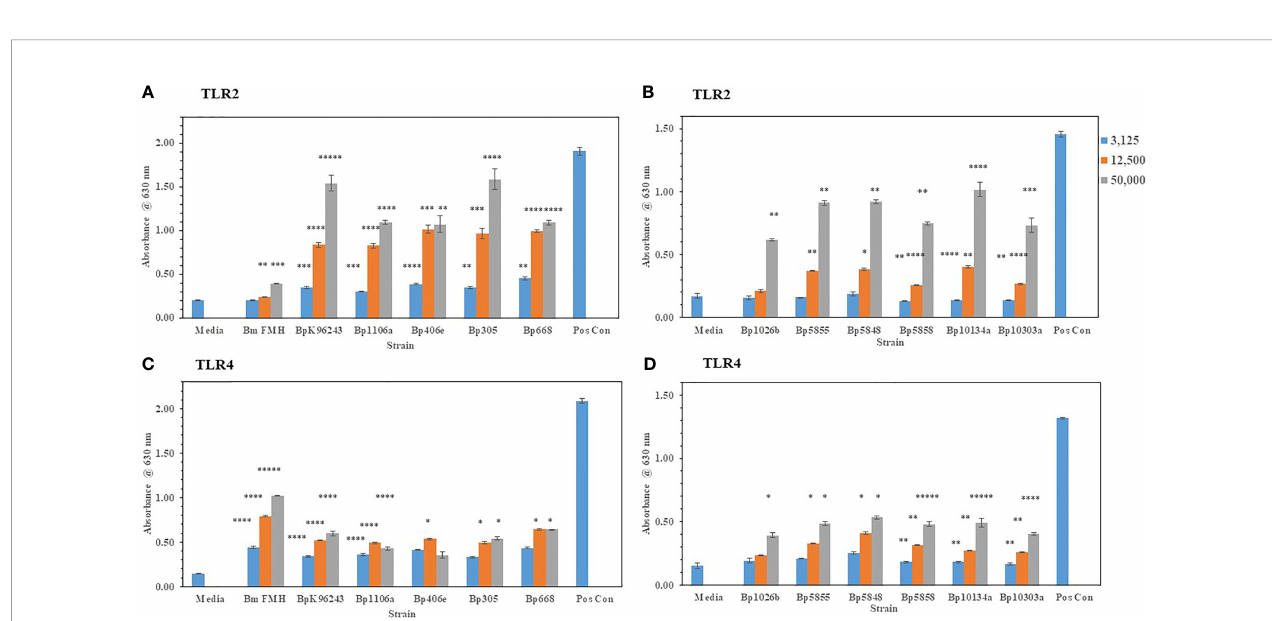
FIGURE 4 | B. mallei ( Bm ) and B. pseudomallei ( Bp ) are closely related species but activate TLR2 and TLR4 differently. Burkholderia spp. were grown at 37°C for ~48 h, and bacterial suspensions were diluted in PBS to inoculate HEK293-TLR2 or -TLR4 cells. The following Burkholderia spp. were evaluated: (A) TLR2: Bm FMH, Bp K96243, Bp 1106a, Bp 406e, Bp MSHR305, and Bp MSHR668; (B) TLR2: Bp 1026b, Bp MSHR 5855, Bp MSHR5848, Bp MSHR5858, Bp HBPUB10134a, and Bp HBPUB10303a. (C, D) are TLR4 incubated with the same strains as listed for (A, B) , respectively. Media controls contained only PBS rather than bacterial cells and positive controls contained either HKLM cells (2 x 10 6 cells) for TLR2 or E. coli LPS (0.2 ng) for TLR4. All samples were analyzed in triplicate, and results represent one of two independent repeats. Results are presented as geometric mean with standard error of the mean. Signi fi cant values compared to media control are shown: * P ≤ 0.05; ** P ≤ 0.01; *** P ≤ 0.001; **** P ≤ 0.0001; ***** P ≤ 0.00001.